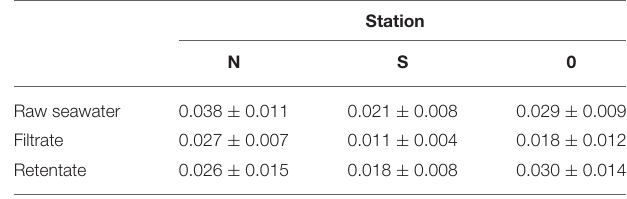
This result indicated that non-living, proteinaceous particle